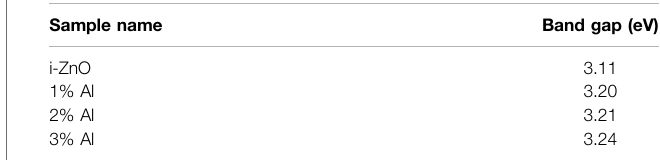
TABLE 2 | Energy Band gap of